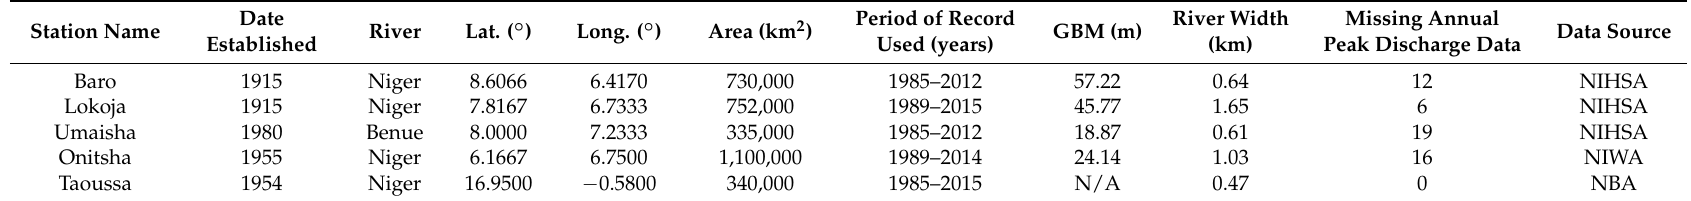
Table 1. In situ gauge station